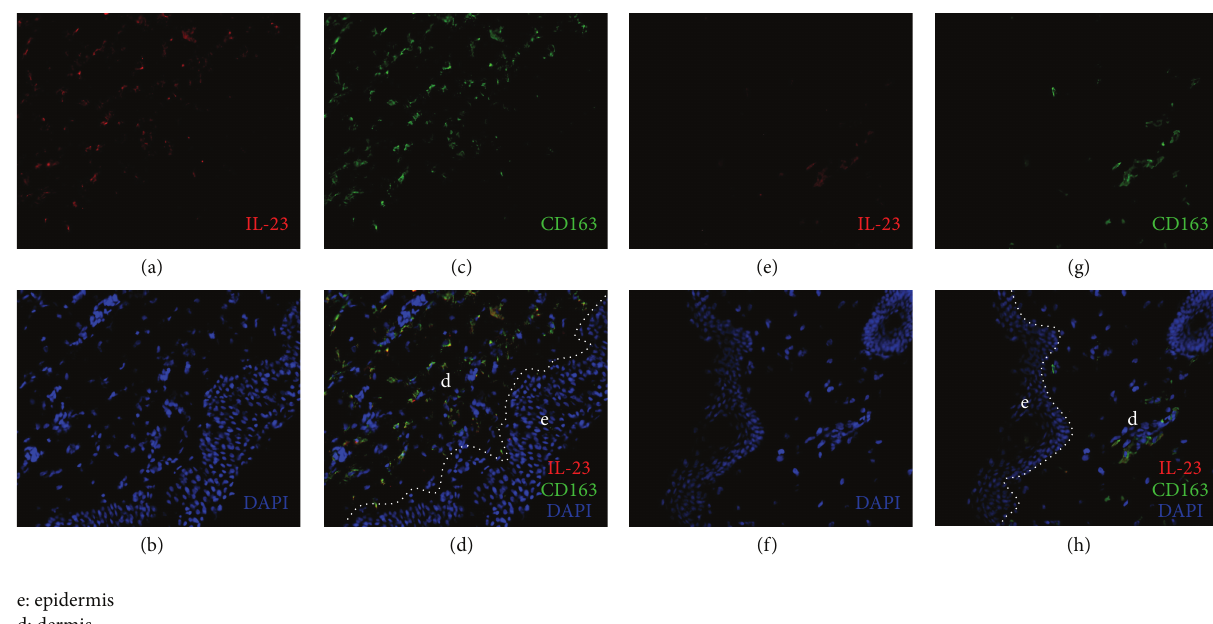
Figure 1: Immunofluorescence studies of specimens from lesions of PV (a–d) and from normal skin of control (e–h). The red and green stained cells were detected by antibodies to IL-23 and CD163, respectively.